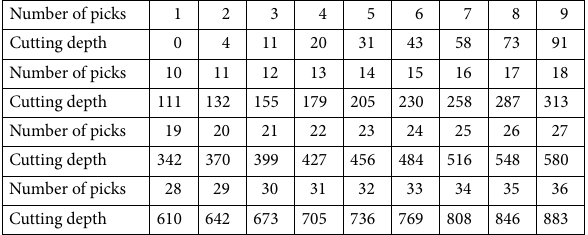
Table 1. Relationship between cutting depth and number of cutting teeth.